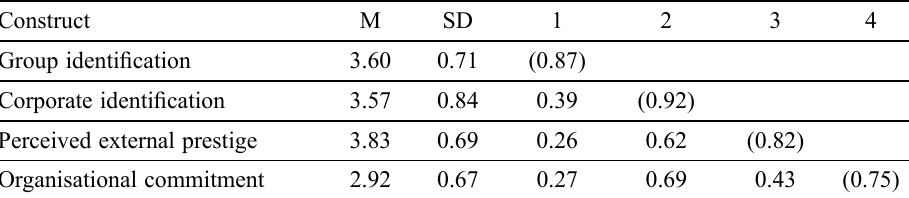
Table 1. Means, standard deviations, correlations and Cronbach’s